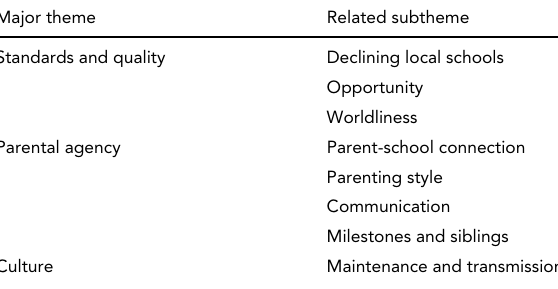
Major Themes and Related